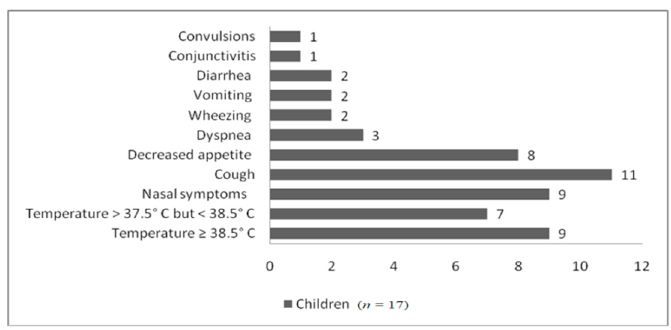
5 of 10 Table 2. Anthropometric measurements of the study group according to SARS-CoV-2 infection status. Characteristics